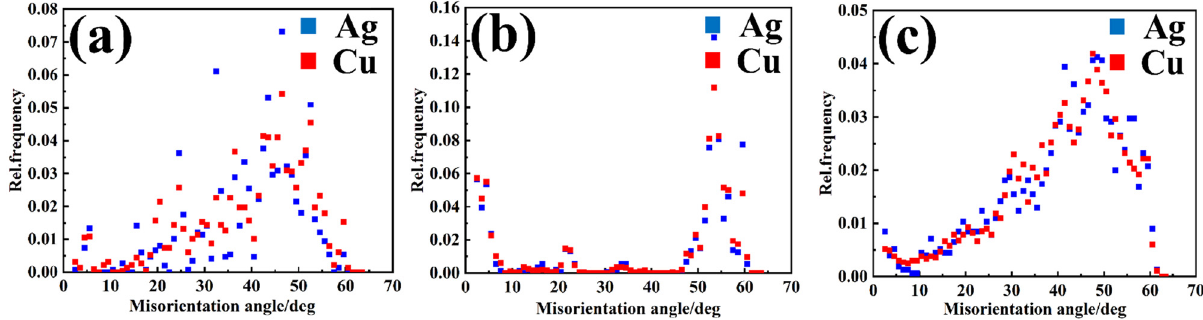
Figure 9: Distribution of the misorientation angle between Ag ( s.s ) and Cu ( s.s ) within the brazing seam. ( a ) 0%; ( b ) 2%; and ( c )